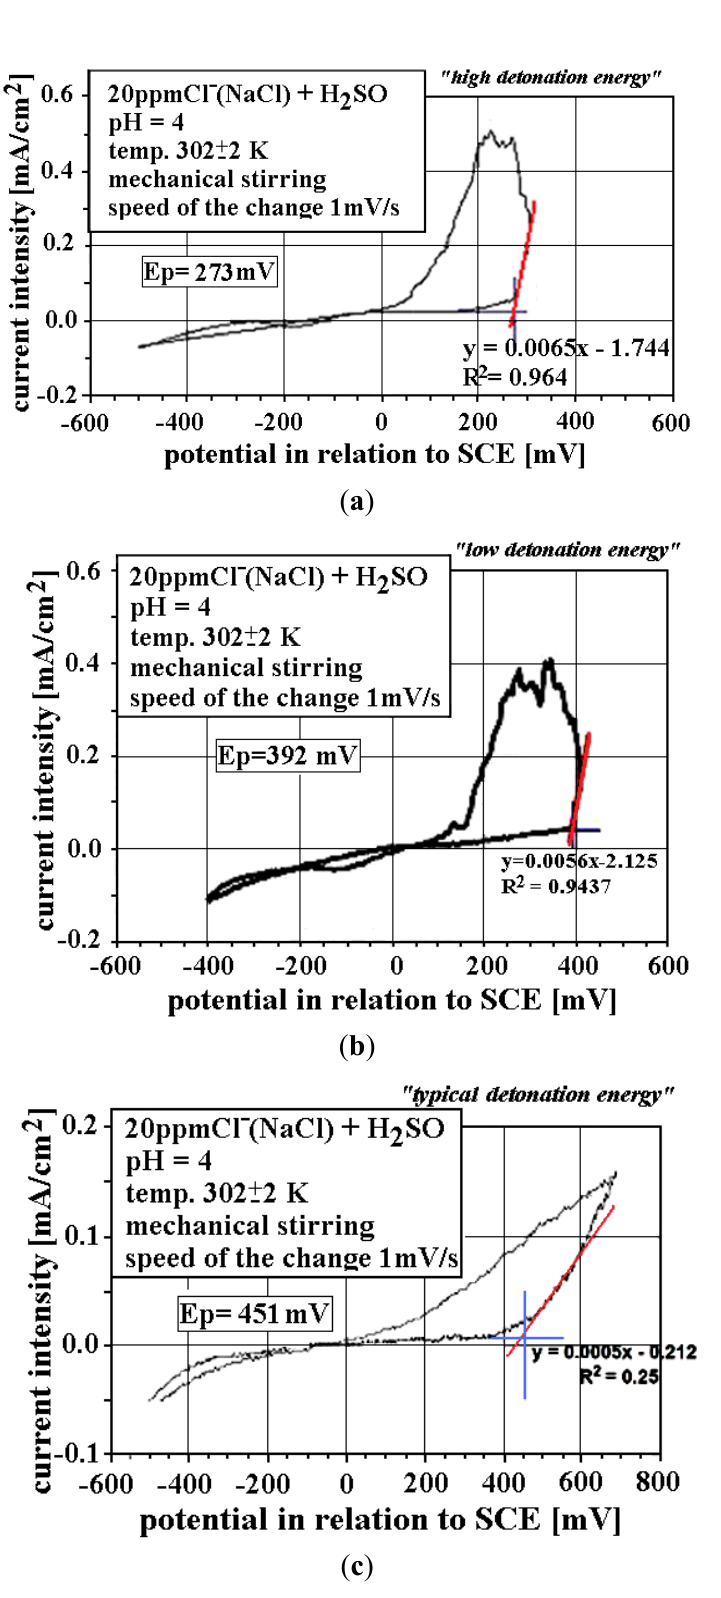
Figure 7. Anodic cyclic polarization curves for FeAl D-gun spraying coatings at the following experimental conditions: 200 ppm NaCl + H 2 SO 4 , pH = 10, t = 302 ± 2 K, mechanical stirring, potential change rate—1 mV/s ( a ); ( b ) FeAl coatings with higher porosity and individual microcracks; and ( c ) FeAl coating with porosity below 0.5% and higher part of Al 2 O 3